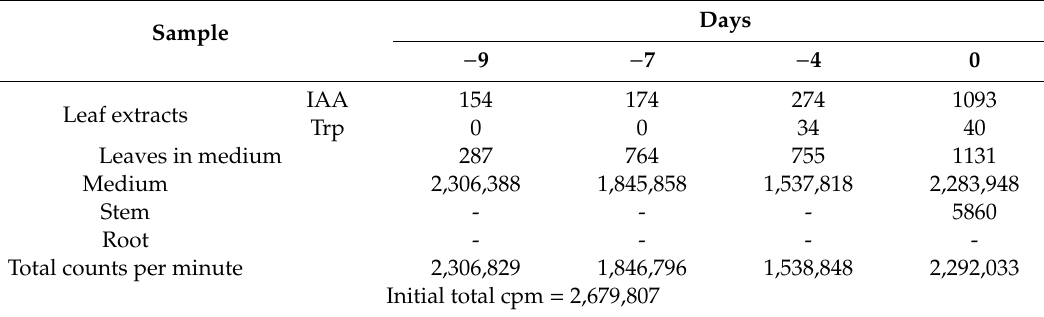
Table 1. Total radioactivity present in each sample of C. canephora plantlets